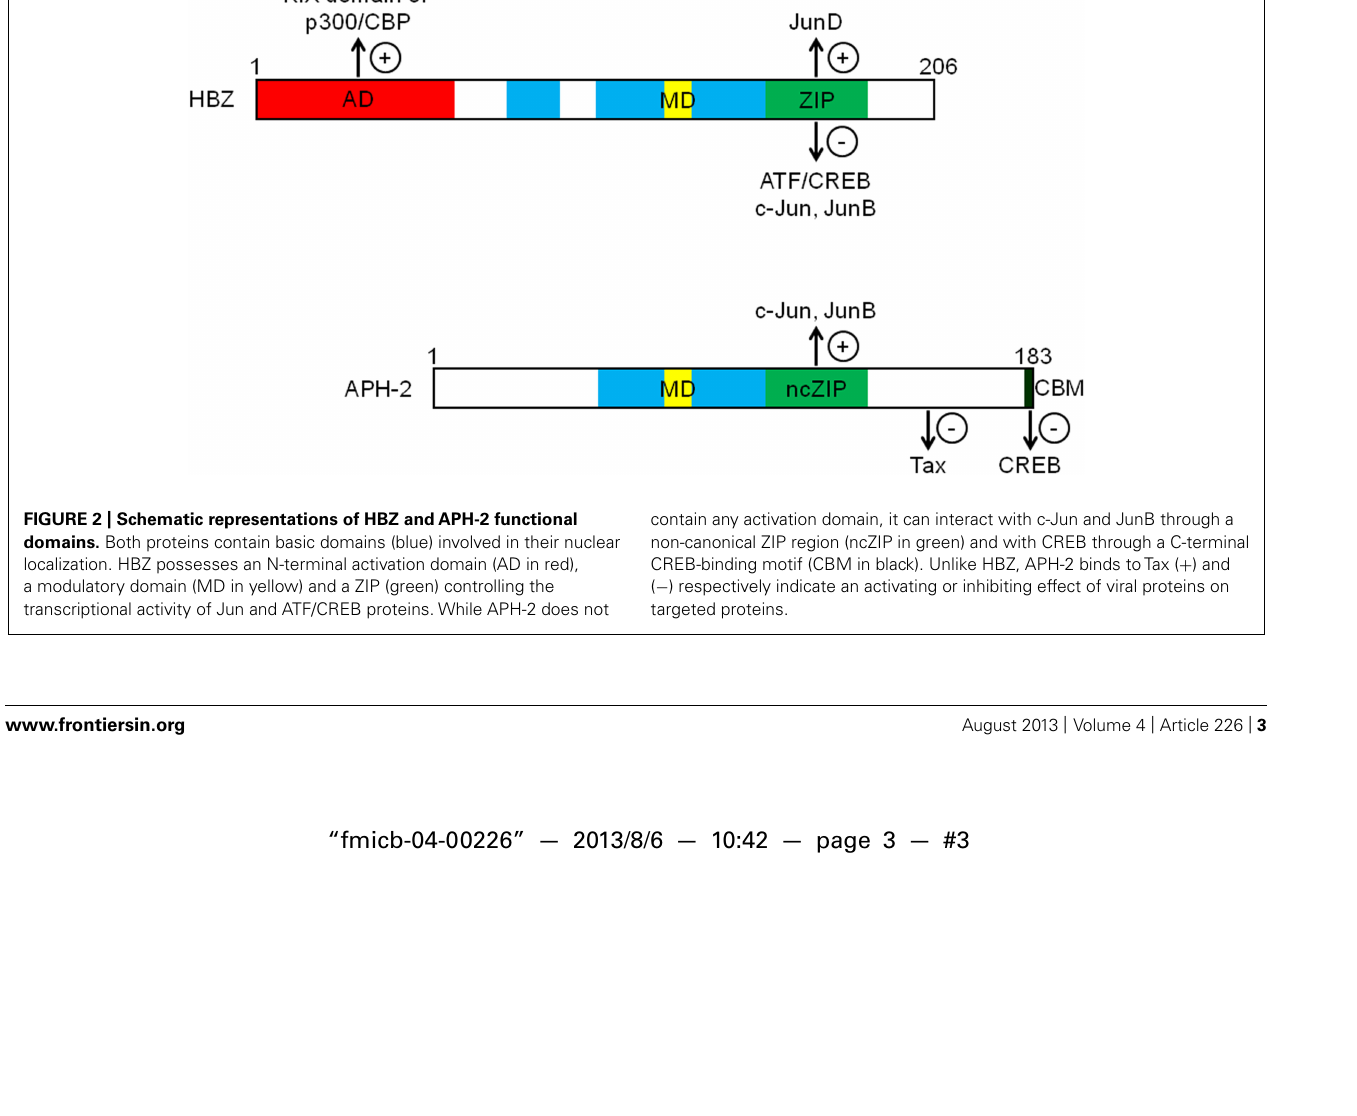
FIGURE 2 | Schematic representations of HBZ andAPH-2 functional domains. Both proteins contain basic domains (blue) involved in their nuclear localization. HBZ possesses an N-terminal activation domain (AD in red), a modulatory domain (MD in yellow) and a ZIP (green) controlling the transcriptional activity of Jun and ATF/CREB proteins.While APH-2 does not